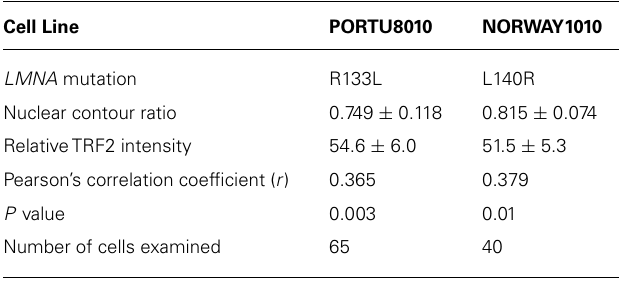
Table 2 | Correlation analysis of nuclear morphological abnormality and reduction ofTRF2 within LMNA mutant primary fibroblast cultures.